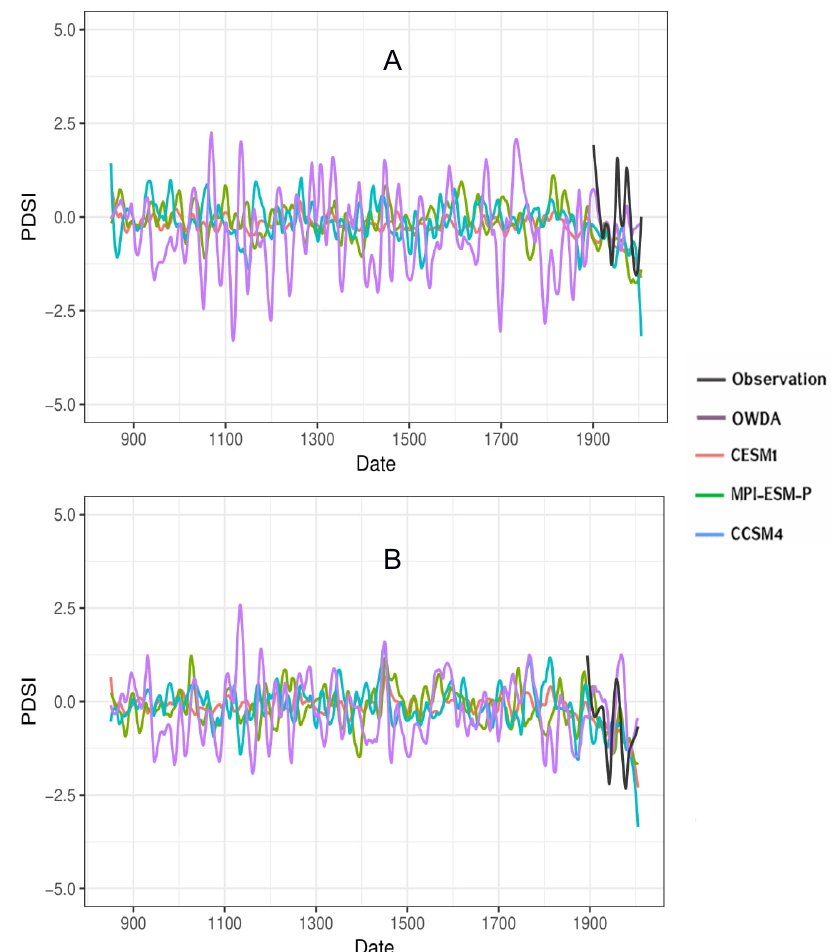
Figure 10. Loess-smoothed time series (30-year window) of summer (June, July, August (JJA)) PDSI in ( A ) Morocco and ( B ) Algeria in 850–2005 for CCSM4, MPI-ESM, and ensemble mean of CESM1 (mean of 10 members), and reconstructed and instrumental dataset (observation) from OWDA. Table 6. Results of modified Mann–Kendall test of trend detection applied to Palmer Drought Severity Index PDSI simulated by CMIP5 models, reconstructed from Old World Drought Atlas (OWDA) over 1850–2005 in Morocco and Algeria. (Red indicates significance, with a p-value <0.05.).